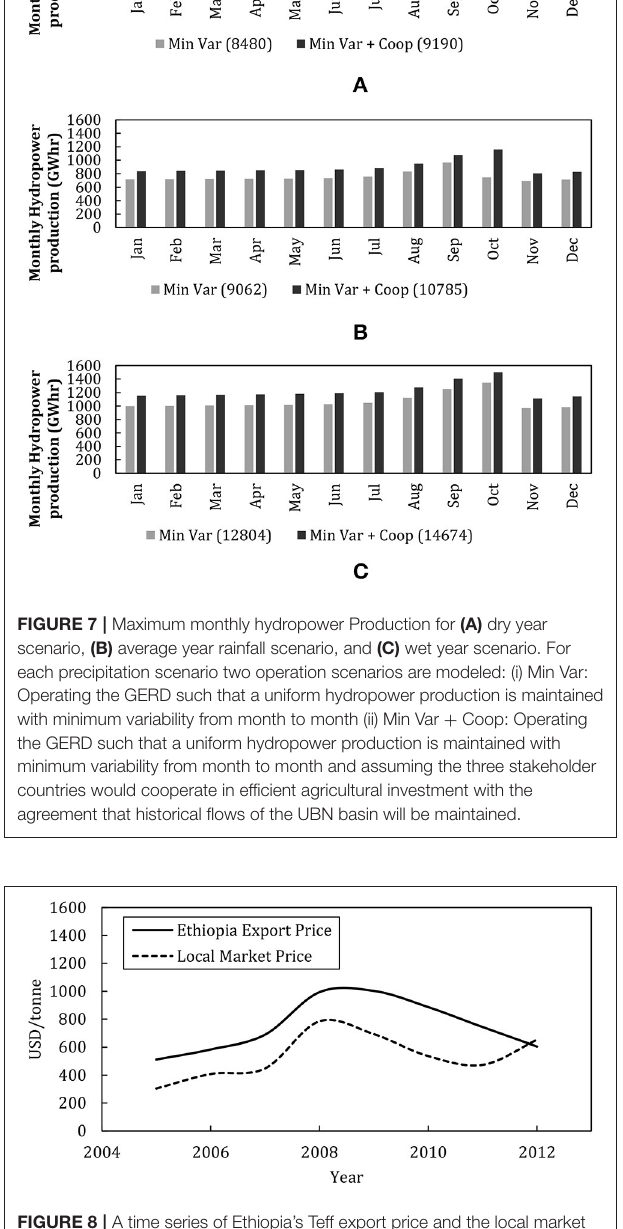
FIGURE 8 | A time series of Ethiopia’s Teff export price and the local market price in Addis Ababa for the years 2005-2012 (Source: The national bank of Ethiopia and ERCA and